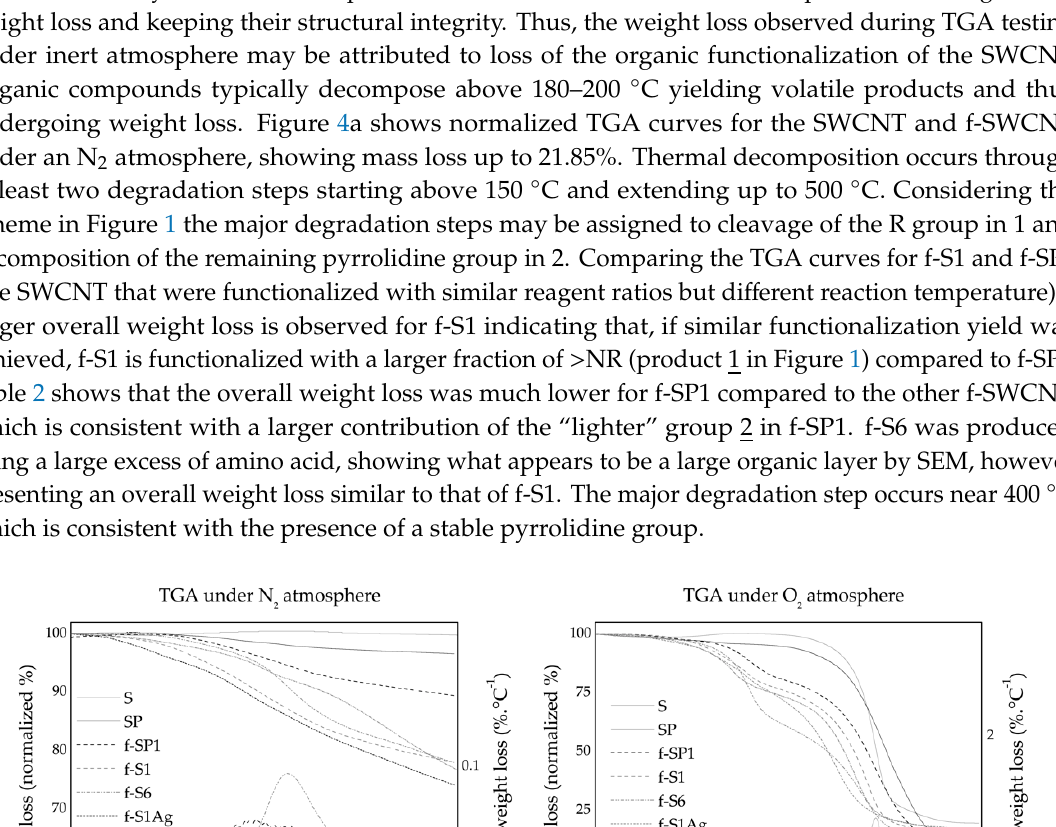
Table 2. TGA results for the analysis performed under nitrogen and under oxygen atmosphere.